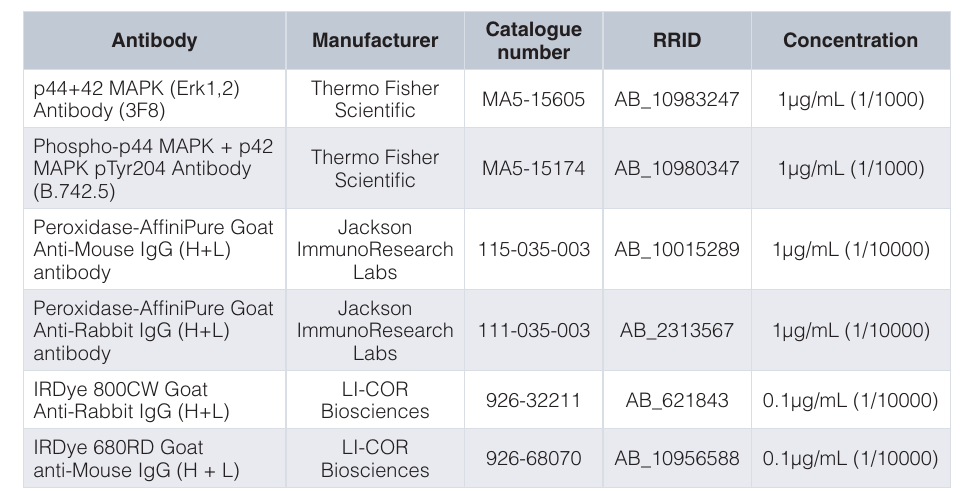
Table 1. Primary and secondary